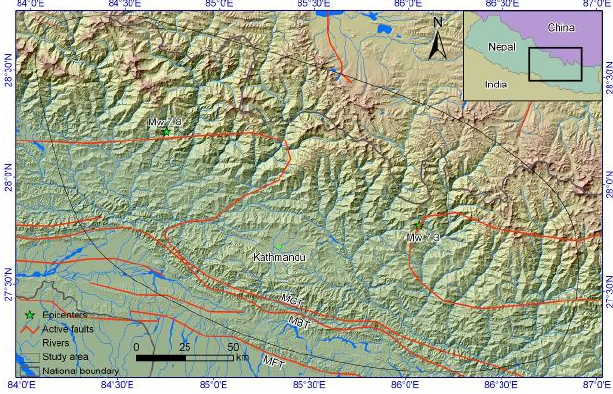
Figure 1. Map showing regional tectonic setting of the 2015 Gorkha earthquake. MFT, Main Frontal Thrust; MBT, Main Boundary Thrust; MCT, Main Central